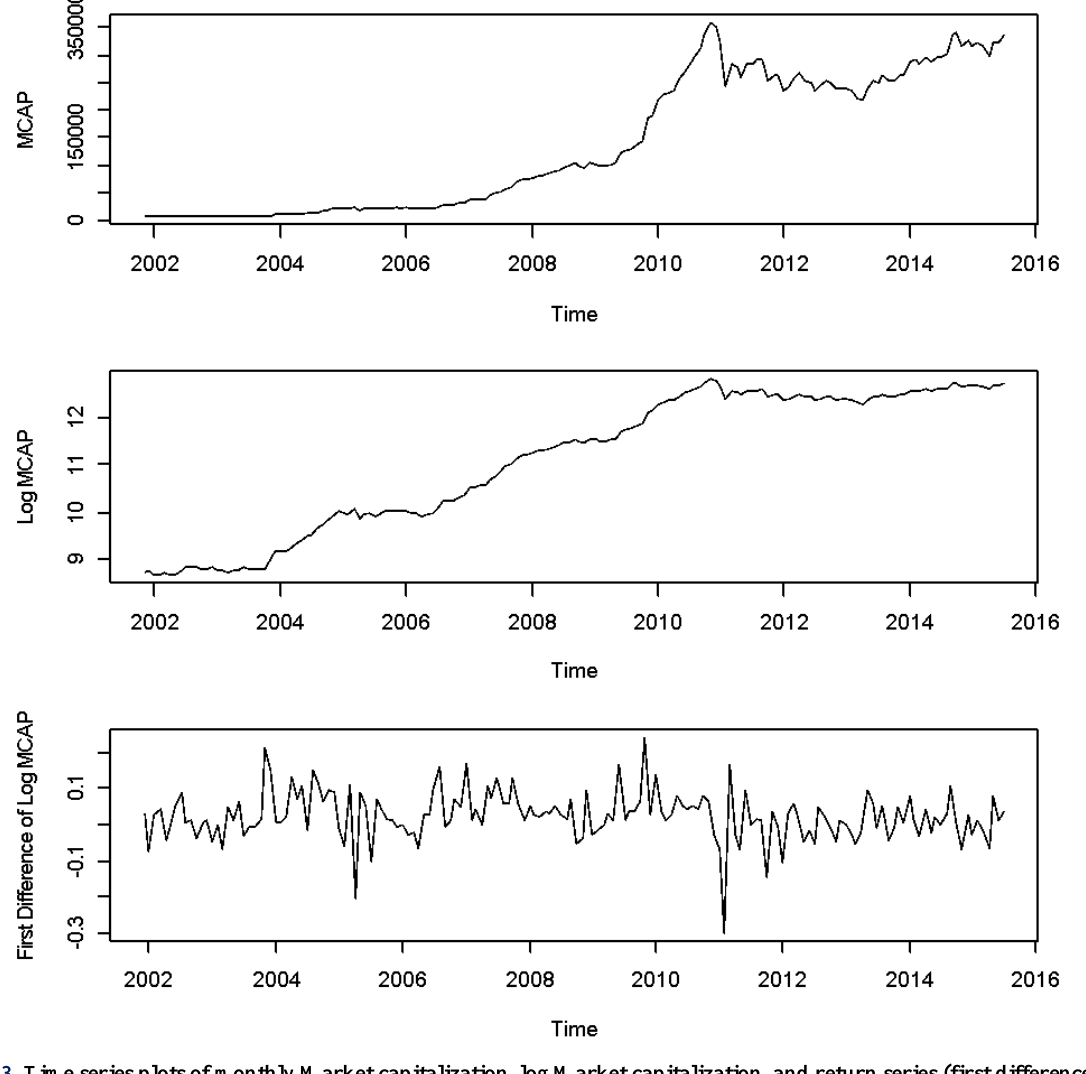
Figure 3. Time series plots of monthly Market capitalization, log Market capitalization, and return series (first difference) of Market capitalization